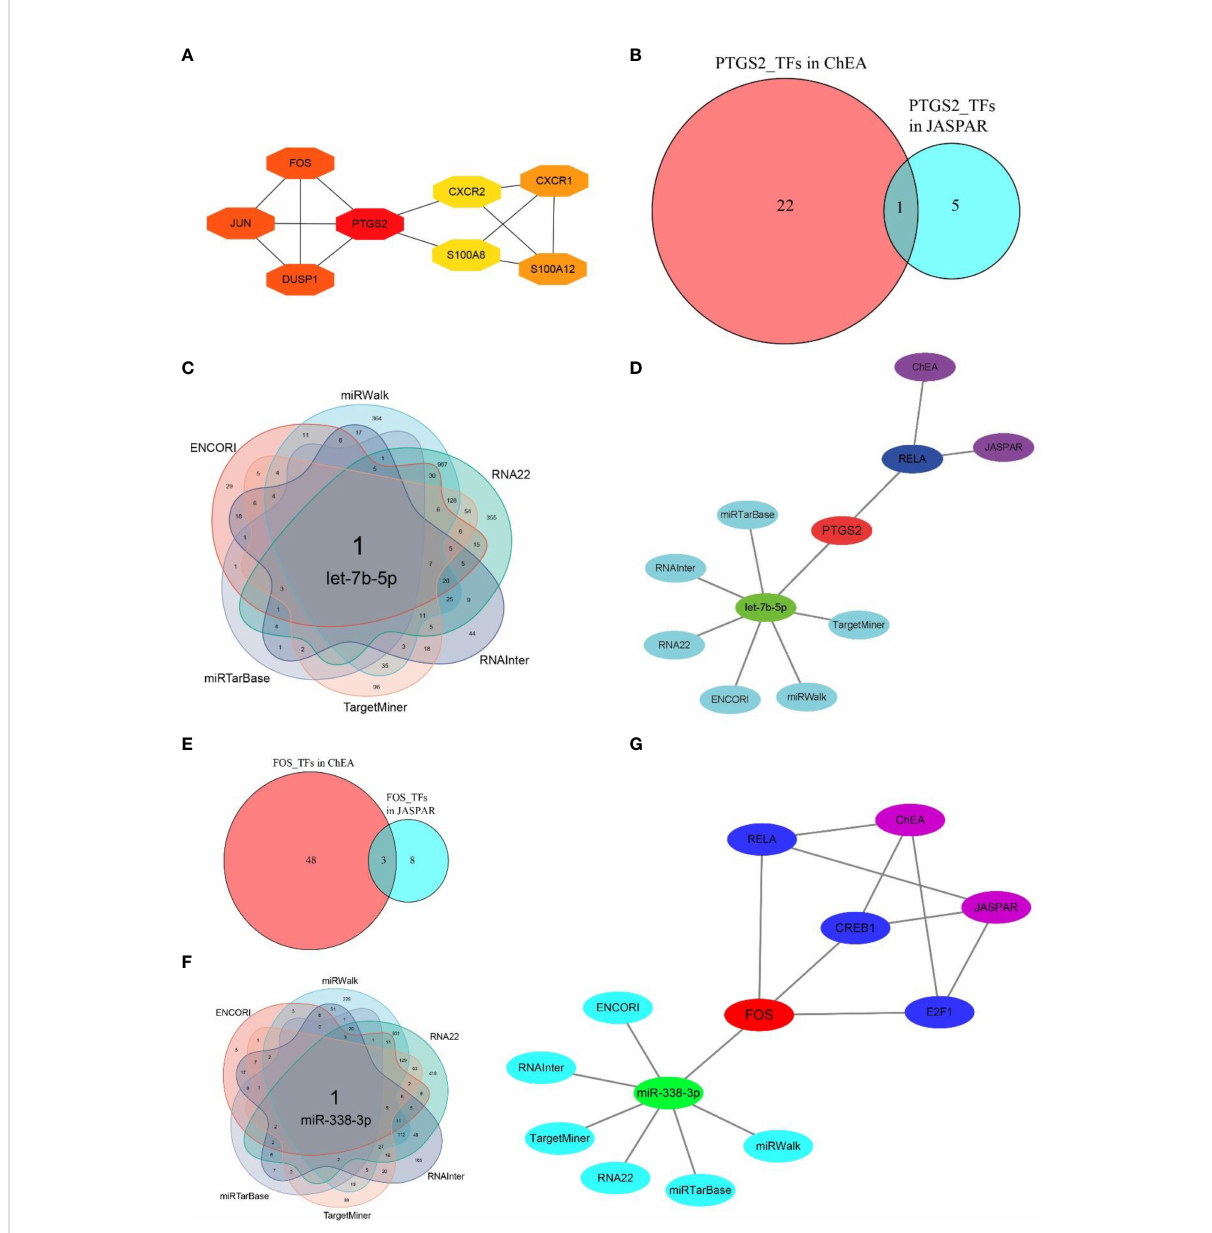
FIGURE 7 Determination of hub regulatory molecules for PTGS2 and FOS. (A) Top eight essential CRGs ranked by MCC scores (NAIP and CLEC4E are not shown because of the absence of interactions with other CRGs), and PTGS scores the highest among 10 hub CRGs. (B) One hub TF targeting PTGS2 was identi fi ed by taking the interaction of TFs from two databases (JASPAR and ChEA). (C) One hub miRNA targeting PTGS2 was identi fi ed by taking the intersection of miRNAs from six databases (miRWalk, RNA22, RNAInter, TargetMiner, miRTarBase, and ENCORI). (D) Hub TFs and miRNAs identi fi ed by multiple databases for PTGS2. (E) Three hub TFs targeting FOS were identi fi ed by taking the interaction of TFs of two databases. (F) One hub miRNA targeting FOS was identi fi ed by taking the intersection of miRNAs from six databases. (G) Hub TFs and miRNAs identi fi ed by multiple databases for